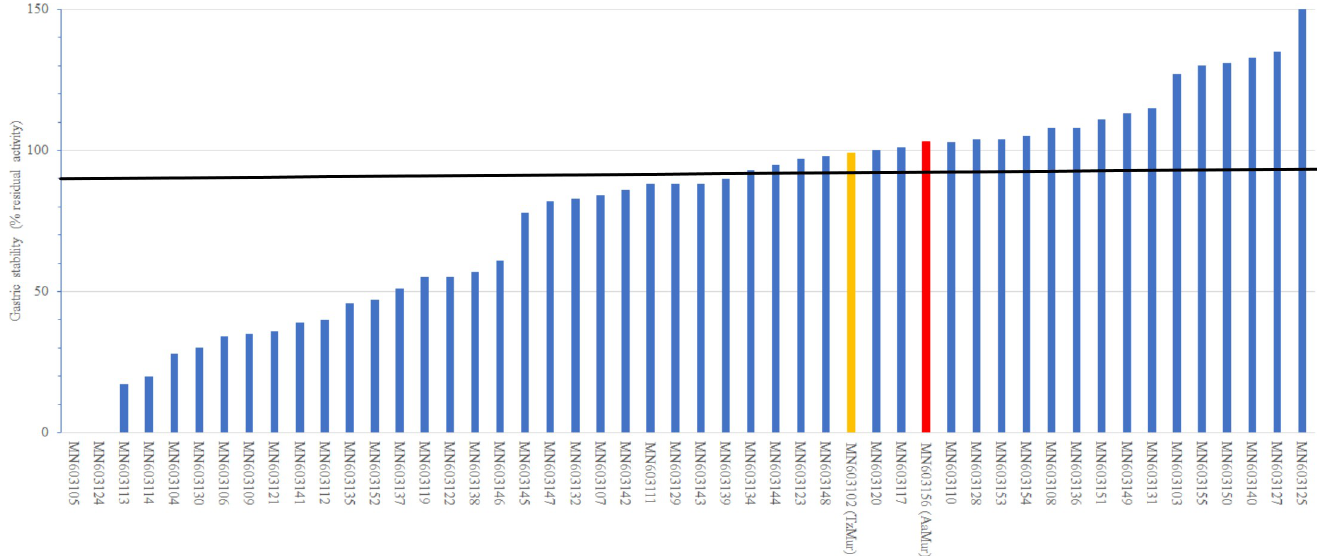
Fig 2. Gastric stability (% residual activity using the OD-drop assay) of the screened muramidases. Aa Mur is coloured red and Tz Mur is coloured yellow. The horizontal line is at 90% survival.